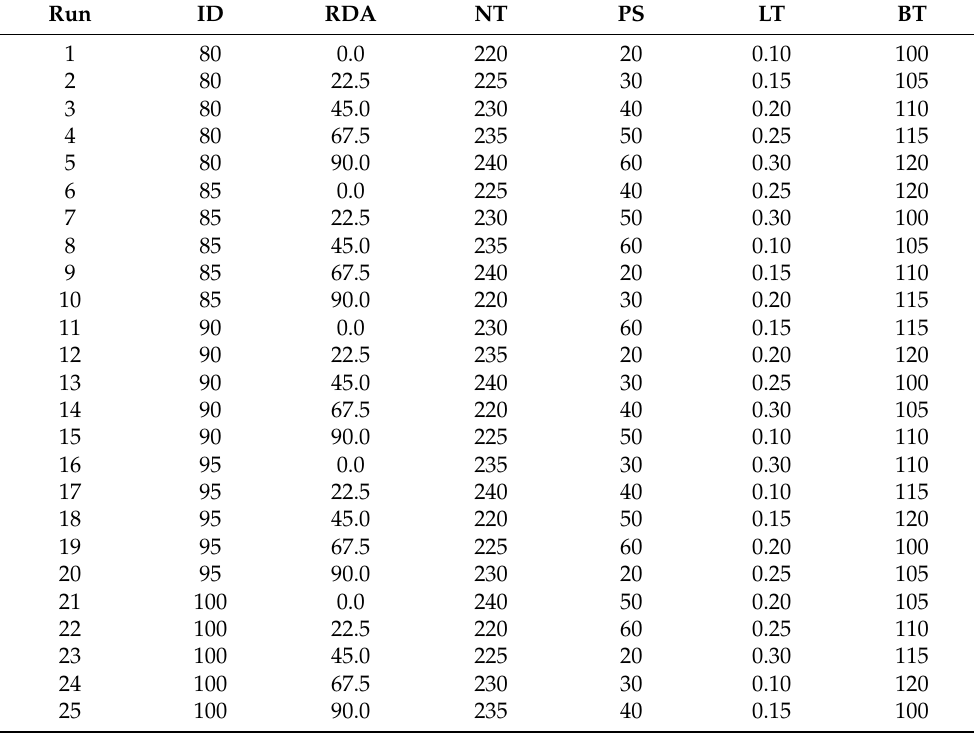
Table 1. Taguchi L25 Design: control parameters and levels.